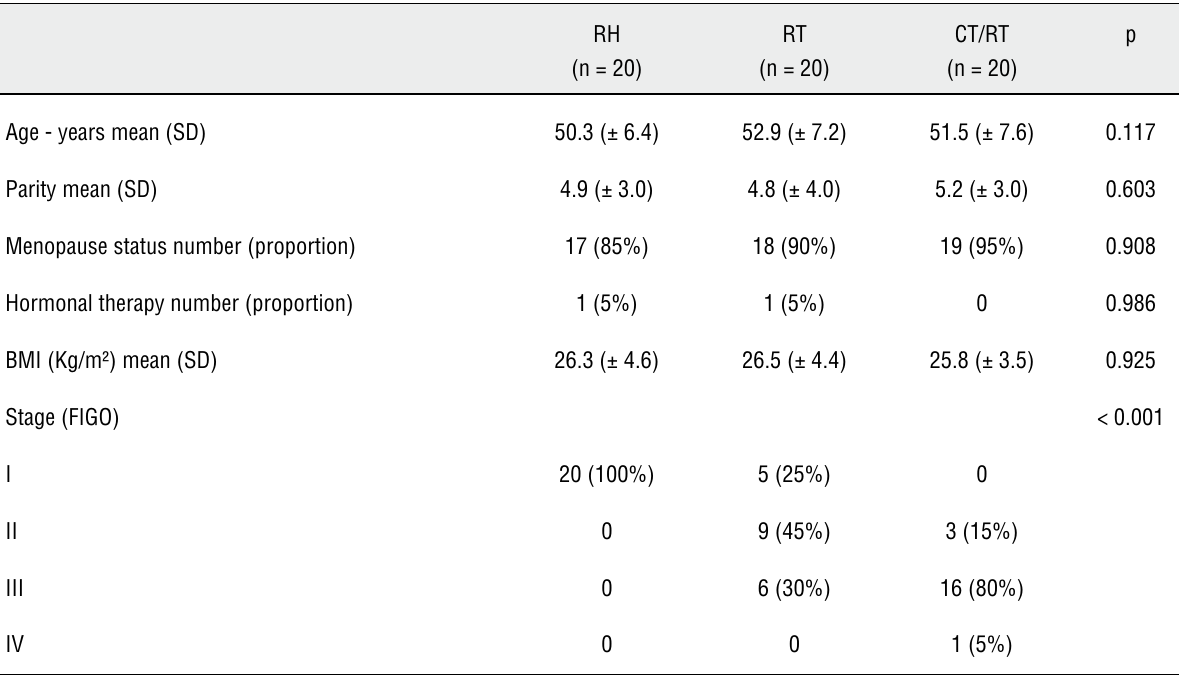
Table 1 - Patient’s clinical characteristics according to treatment